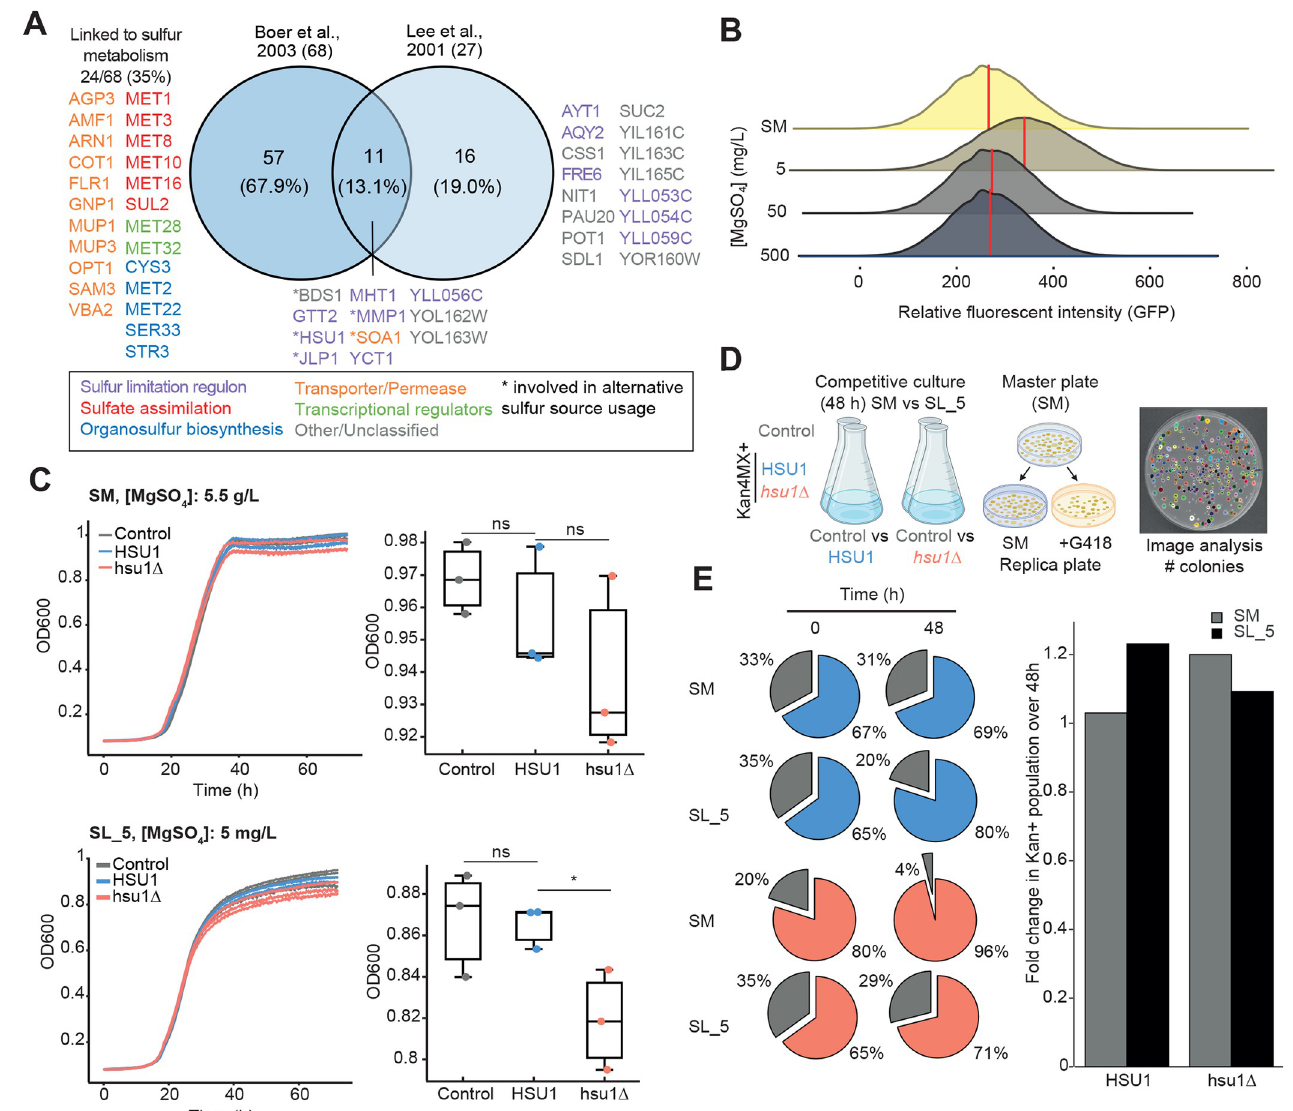
Fig 4. Hsu1p confers a growth advantage under prolonged sulfur limitation in the presence of Met17p. (A) Comparison of genes identified by transcriptomics that are up-regulated under sulfur limitation against genes identified as part of the sulfur limitation regulon regulated by Met4p [39,40].Of the 68 genes up-regulated in response to sulfur limitation, 24 (35%) have functional annotations related to sulfur metabolism or transport. Gene functions are classified as indicated. � indicates gene products that have a defined enzymatic function related to the usage of alternative sulfur sources. (B) Profiling of Hsu1-GFP by flow cytometry in a prototrophic strain exposed to sulfur limitation conditions via titration of MgSO 4 (mg/L). SM indicates minimal media containing standard concentrations of (NH 4 ) 2 SO 4 (5 g/L) and MgSO 4 (500 mg/L) giving a total sulfate concentration of 5.5 g/L. Histograms indicate population of GFP+ cells measured ( > 20,000); red line indicates relative median fluorescence intensity of the captured population. (C) Growth profiles and endpoint OD 600nm of control, HSU1 , and hsu1 Δ strains under sulfur-replete (SM) and limited (SL_5) conditions. All strains express MET17 due to the repair of auxotrophies via plasmid complementation with pHLUM. Opposed to the HSU1 ( his3 Δ ) and hsu1 Δ strains, the control strain does not harbor any gene knockout and is Kan − . The HSU1 strain is his3 Δ , which serves to control for the position effect of the Kan4MX cassette, thereby making it comparable to hsu1 Δ . (D) Setup of a growth competition assay competing the control strain with either HSU1 or hsu1 Δ strains grown in SM vs. SL_5. Since both knockout strains harbor a Kan4MX cassette their frequency can be assessed by replica plating onto SM ± G418. The number of positive colonies can be counted via image analysis and presented as a ratio between the two replica plates per condition and per time point. (E) Frequency of Kan+ and Kan − populations across all conditions and time points tested (pie charts). Adjacent barplot summarizes the fold change in Kan+ populations over 48 h between SM and SL_5 conditions. The data underlying this figure can be found in S1